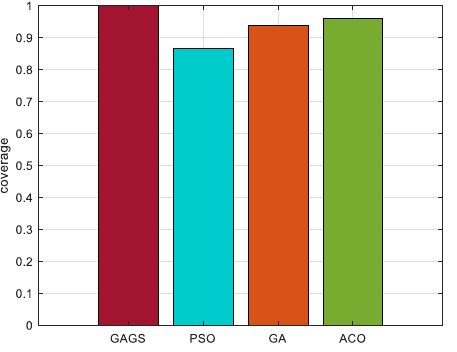
Figure 12. Histogram of algorithm coverage comparison after increasing the coverage model attenuation factor. After increasing the attenuation factors α , β , GAGS achieves full coverage with 684 WSN nodes, while when deploying the same number of nodes, the coverage rate of PSO is only 86.6%, the coverage rate of GA is 93.79%, and that of ACO reached 96.04%. It reveals that the GAGS algorithm still has superiority in coverage